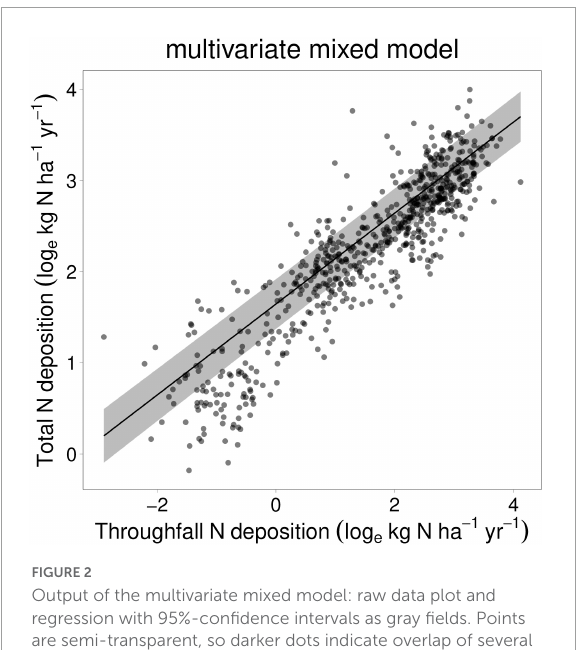
FIGURE2 Output of the multivariate mixed model: raw data plot and regression with 95%-confidence intervals as gray fields. Points are semi-transparent, so darker dots indicate overlap of several points.